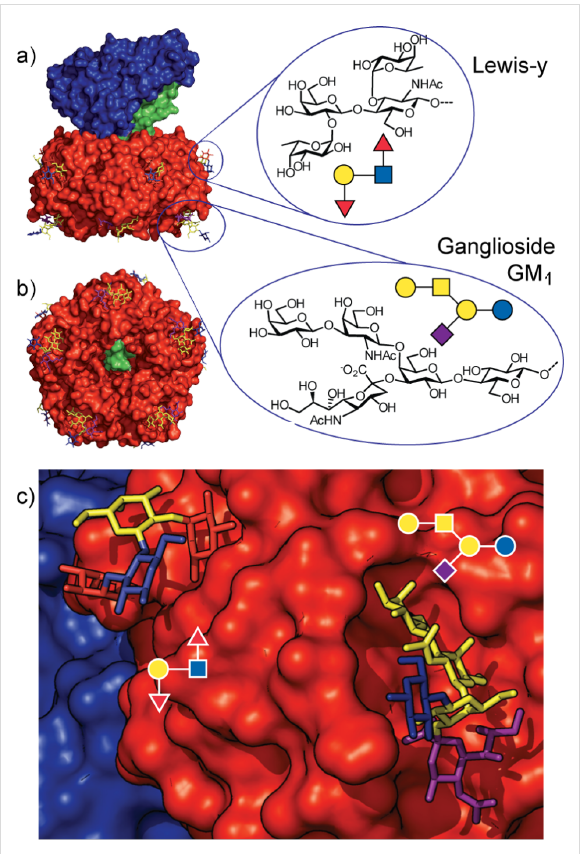
Figure 2: a) Structure of the cholera toxin showing the location of its carbohydrate binding sites and the structures of the Lewis-y and Ganglioside GM 1 ligands; A-subunit (blue), B-subunit (red) and the A2 peptide linker (green). b) Bottom face of the toxin showing the symmetry of the B-subunit and the A2 peptide linker emerging through the central channel. c) Close-up view of the two sugar binding sites. Figure prepared using the PyMOL programme from Protein Data Bank files 1XTC.pdb, 3CHB.pdb and